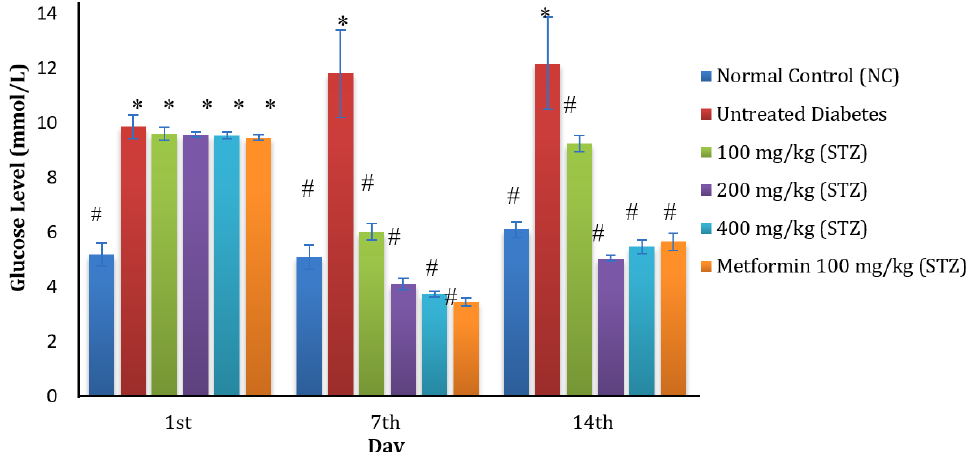
Figure 1 Effect of MPMTE on glucose level (mmol/L). Glucose levels of normal rats and STZ-induced diabetic rats were measured per week. The values are mean ± SEM (n=6/group).